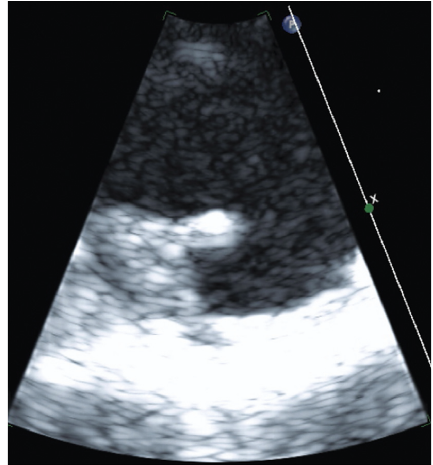
Figure 4: Magnified short-axis aortic view of 12mm aortic arch